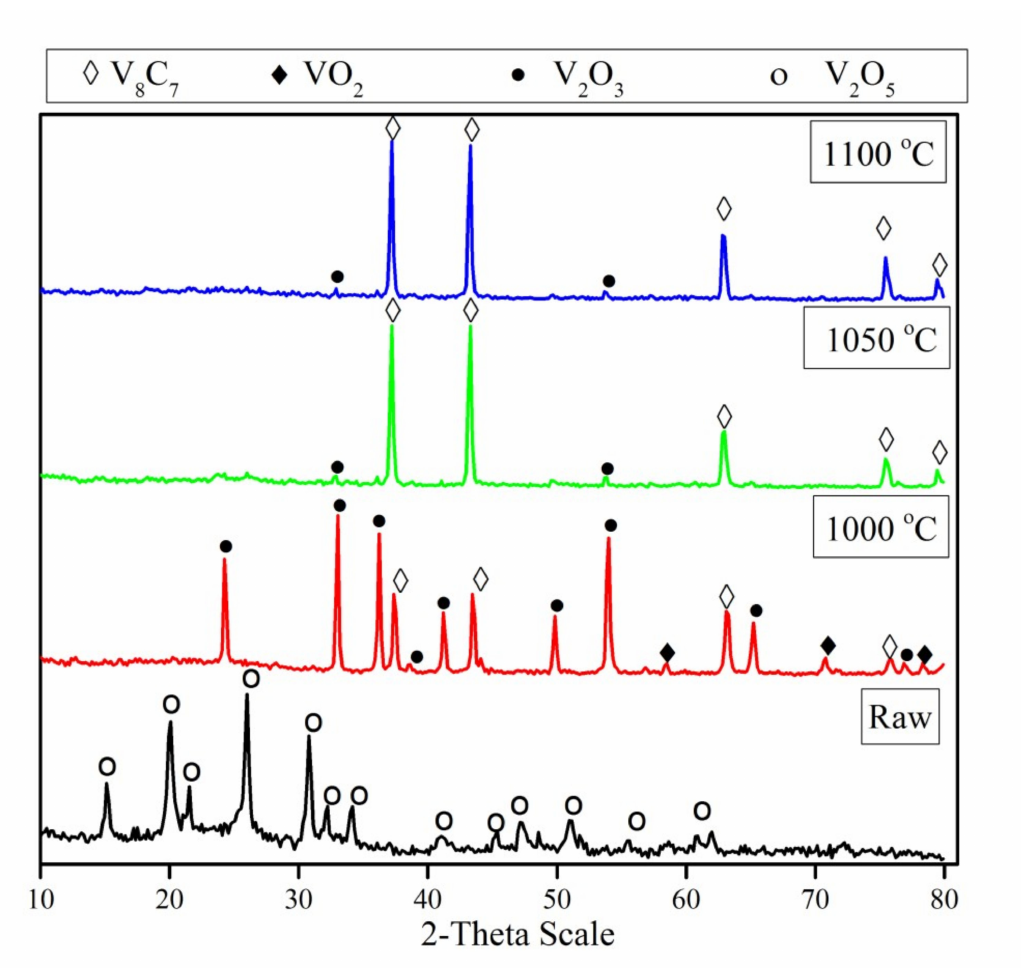
Figure 3. XRD patterns of un-milled, and reduction products of 15 h milled, V 2 O 5 -C mixture at temperature range 1000–1100 ◦ C for 1